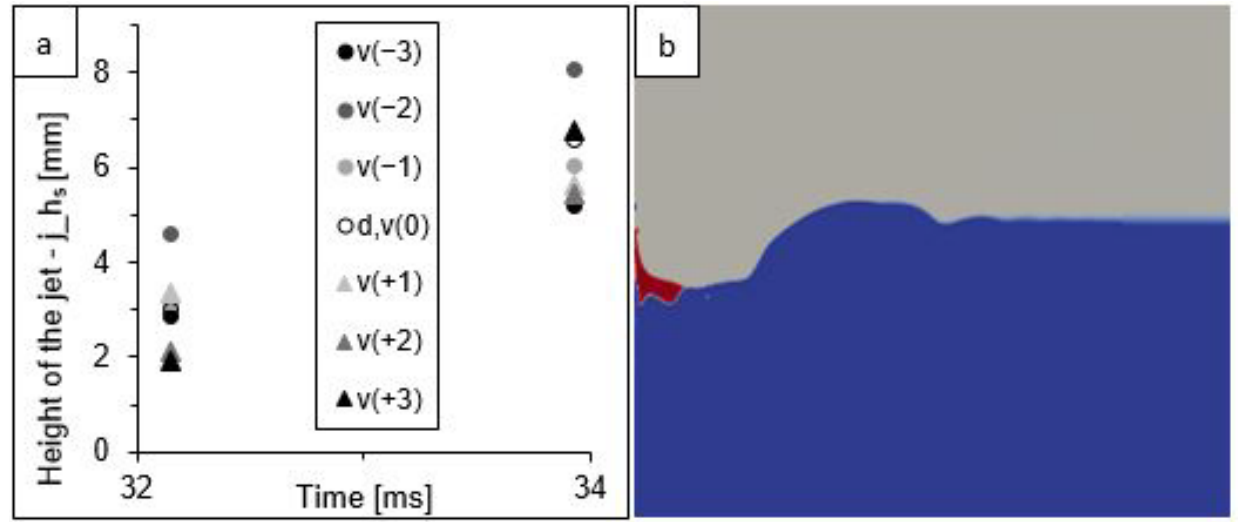
Figure 9. A jet: ( a ) changes in the jet height in a function of time for seven models of velocity variants; ( b ) an example of jet simulation at 32 ms for model d,v(0)—the colours signify: water (blue), petrol (red), and air (grey).